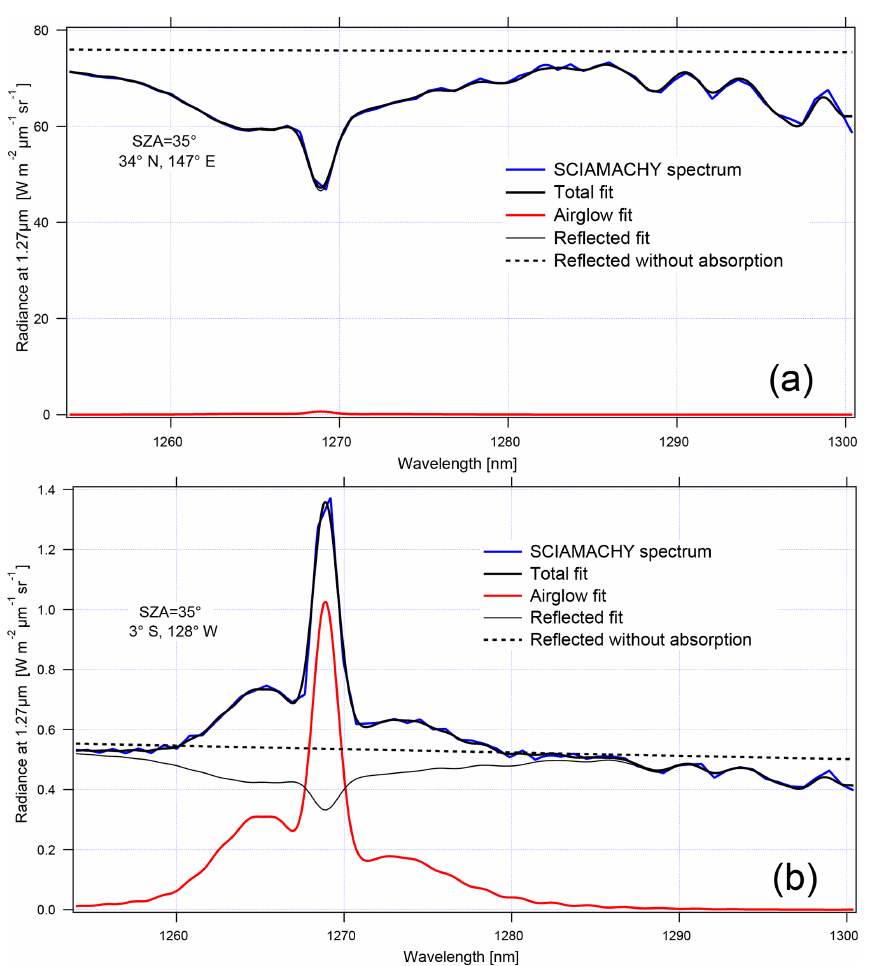
Figure 16. Two examples of SCIAMACHY spectra at nadir: (a) above thick clouds and (b) above clear ocean. The SCIAMACHY spectrum is in blue, fitted spectrum in thick black, determined airglow spectrum in red, fitted reflected spectrum in light black, and reflected spectrum without absorption in dotted black. The word “radiance” in the label axis indicates the spectral radiance or intensities.